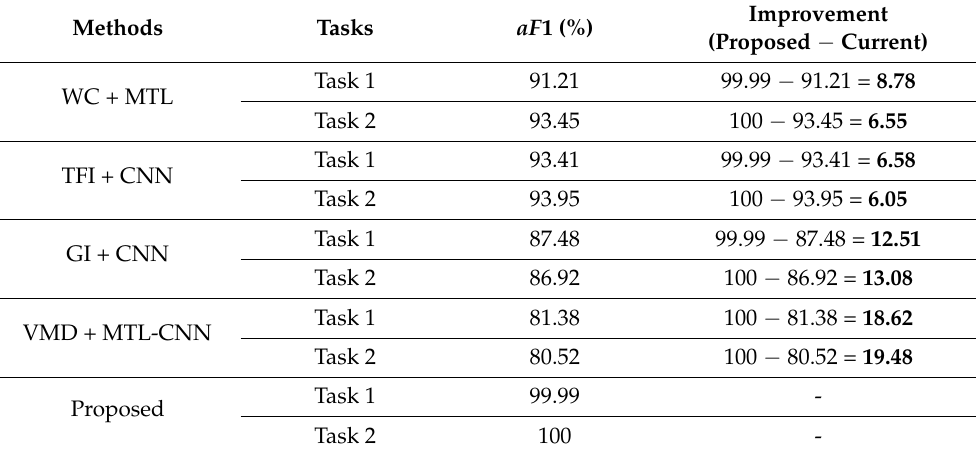
Table 4. Comparison analysis for case study